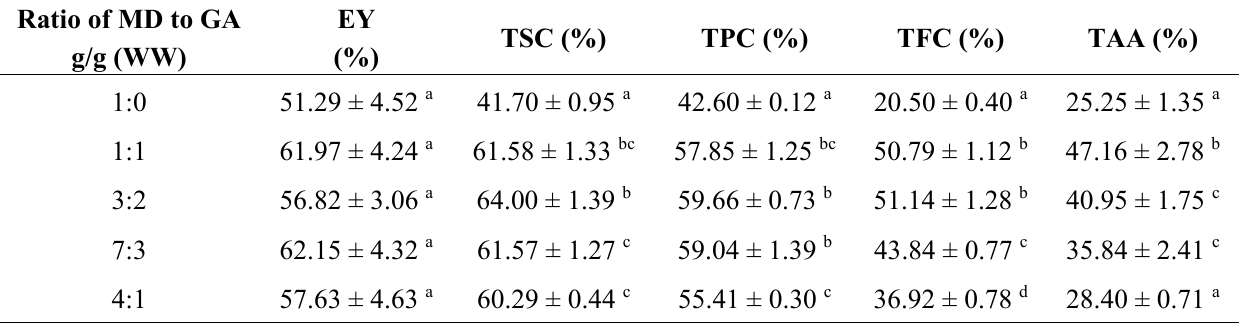
Table 2. The effect of different ratios of maltodextrin (MD) to gum Arabic (GA) on the encapsulation yield (EY) and the retentions of total saponin content (TSC), total phenolic content (TPC), total flavonoid content (TFC) and total activity activity (TAA) of the encapsulated